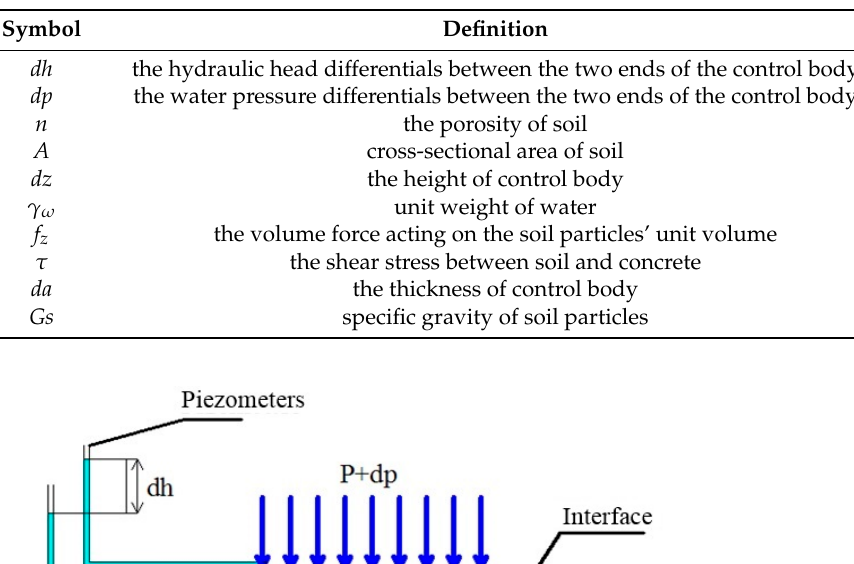
Table 8. Definition of symbols.